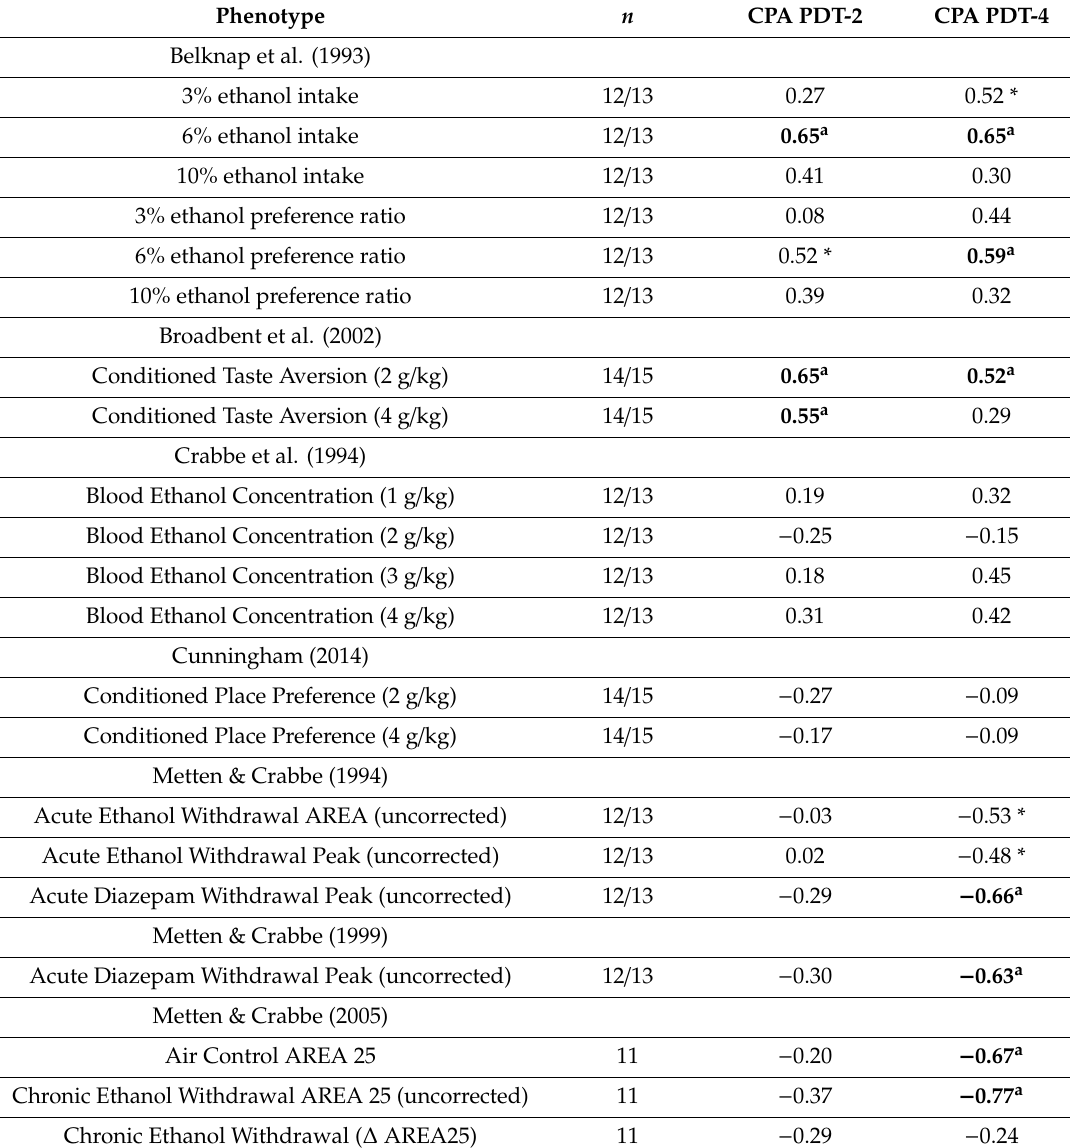
Table 2. Genetic correlations (Pearson r ) between CPA and other ethanol